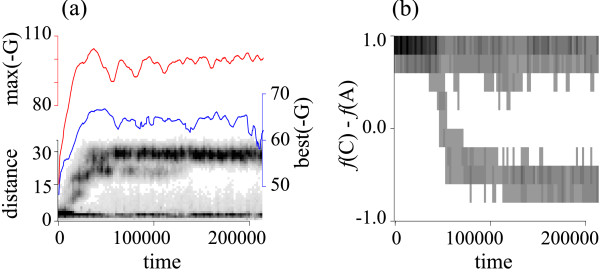
Dynamics of speciation. (a) Evolutionary dynamics of the G-parasite. The abscissa is time in simulation steps. There are three kinds of ordinate: (1) The ordinate labeled as distance (black) is the Hamming distance between the C-catalyst and non-catalytic molecules that have a stronger affinity to the C-catalyst than to the A-catalyst (for each of the chosen non-catalytic genotypes, the catalytic genotype that gives the strongest affinity to it is used to calculate the distance). The affinity is measured in the G score. The distinction between the C- and A-catalyst was done from the sequence composition of their 5-'dangling-end. Gray scale represents the frequency (occurrence) of phenotypes (the more frequent, the darker). The frequency was averaged over ca. 2000 time steps (100 bins). The plots are based on the top 1000 most abundant phenotypes chosen each from catalytic and non-catalytic replicators at every 500 time steps (this is also the case in (b); for the definition of phenotypes, see "Construction of phylogenies"). (2) The ordinate labeled as max(-G) (red) is the average of the theoretical maximal affinity of G-parasites (the sequences in the upper branch of the Hamming distance distribution are the G-parasites). (3) The ordinate labeled as best(-G) (blue) is the average of the maximal affinity G-parasites can gain from the C-catalyst. (b) Evolutionary dynamics of the A-catalyst. The abscissa is time. The ordinate is the frequency of C's minus that of A's in the 5'-dangling-end of catalytic molecules. Gray scale represents the number of occurrence of phenotypes. The frequency was averaged in the same way as in the Hamming distance in (a).